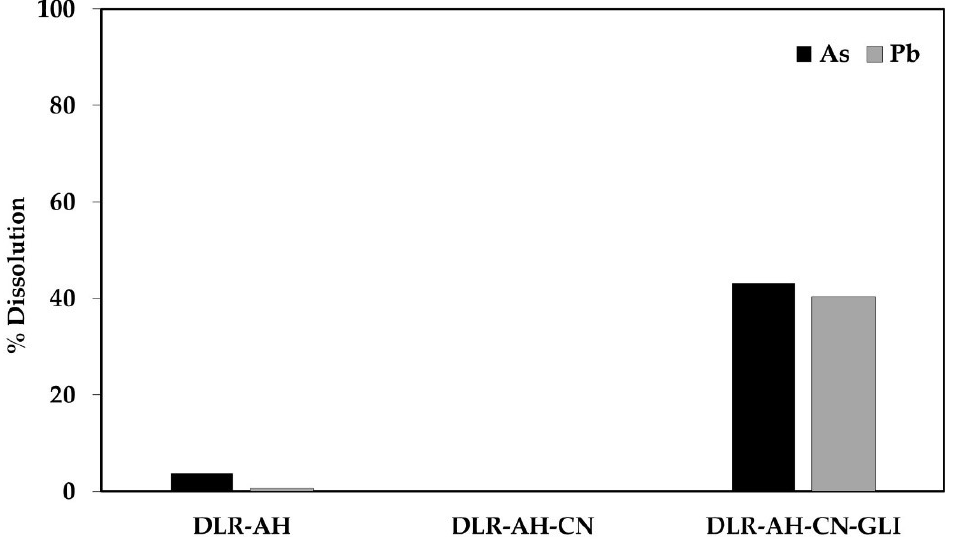
Table 5. Concentration of As, Pb, Fe, and S of the liquid samples obtained during the DLR-AH pretreatment and the conventional and glycine-assisted cyanidation.